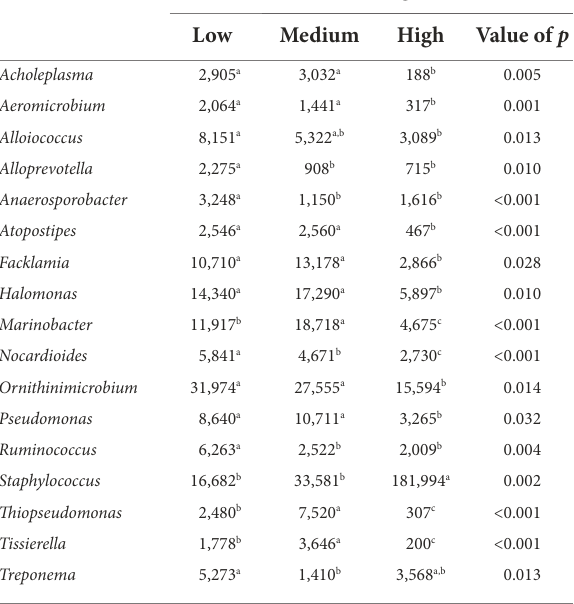
TABLE 7 Bacterial genera relative abundance (ppm) in the milk samples of Holstein dairy cattle associated with different somatic cell count (SCC) ranges at time of collection: low, medium, and